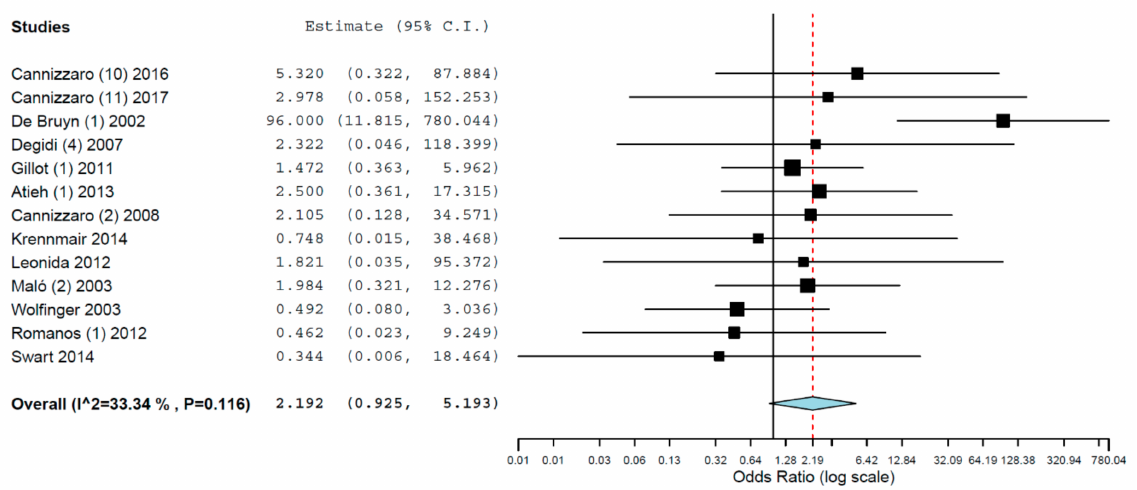
Figure 3. Forest plot for the event ‘implant failure’, studies evaluating implants inserted exclusively in mandibles. Estimate in Odds